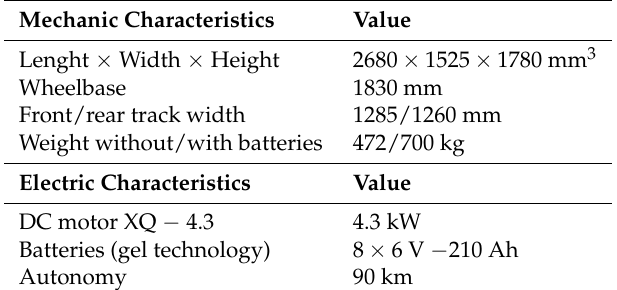
Table A1. Main characteristics of the prototype vehicle.